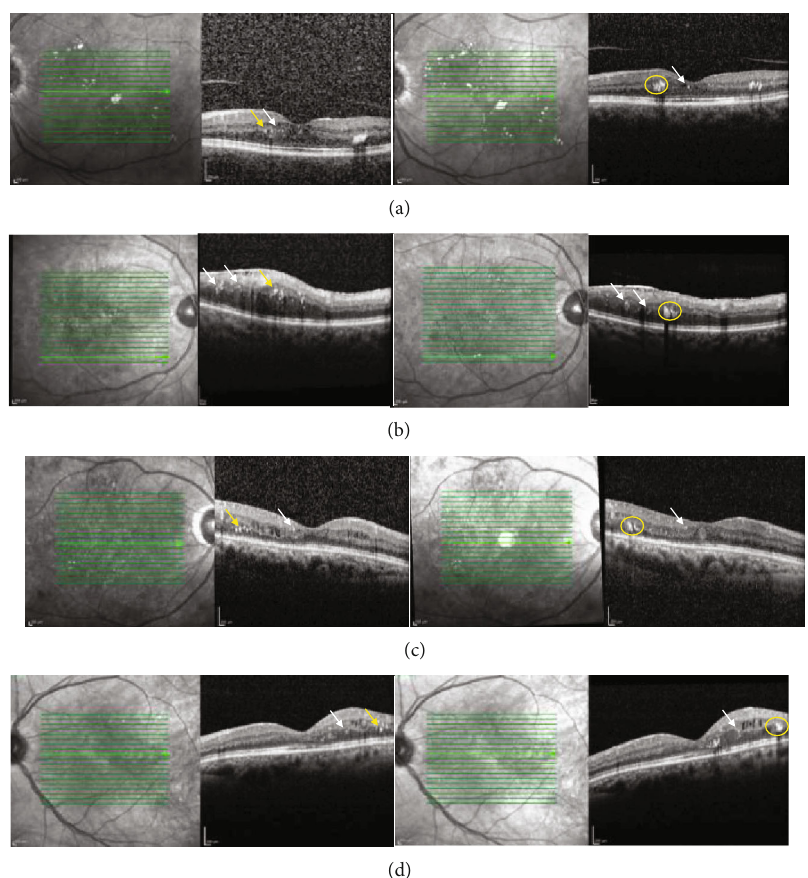
Figure 6: Accumulation of large hyperre fl ective foci (HF) to form hard exudates (HE) in patients with diabetic macular edema (DME) after anti-VEGF therapy. Figure shows infrared images and corresponding spectral-domain optical coherence tomography (SD-OCT) scans at (left panel, a – d) baseline and (right panel, a, b) two months or (right panel, c, d) one month after anti-VEGF injection. In the region of interest on SD-OCT, large HF (yellow arrows) in the outer retinal layers (outer plexiform layer (OPL) and outer nuclear layer (ONL)) increase in density and area to form HEs (yellow circles), which are visible on corresponding infrared images (right panel, a, b). Small HF (white arrows), which might resemble phagocytising macrophages, are scattered through all retinal layers and do not change in number or size after